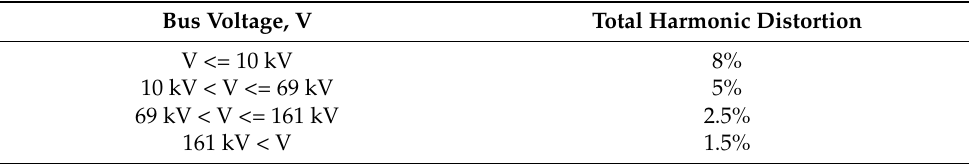
Table 5. Allowable total harmonic distortion (THD) value according to the IEEE 519-2014 standard.